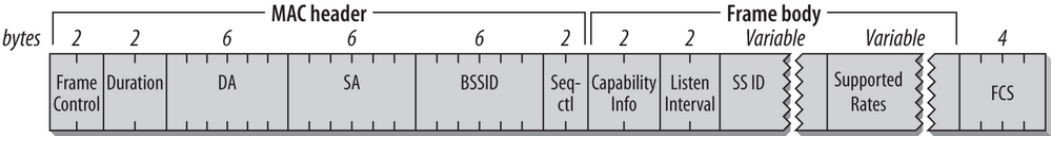
Figure 2. Wi-Fi Probe Request frame